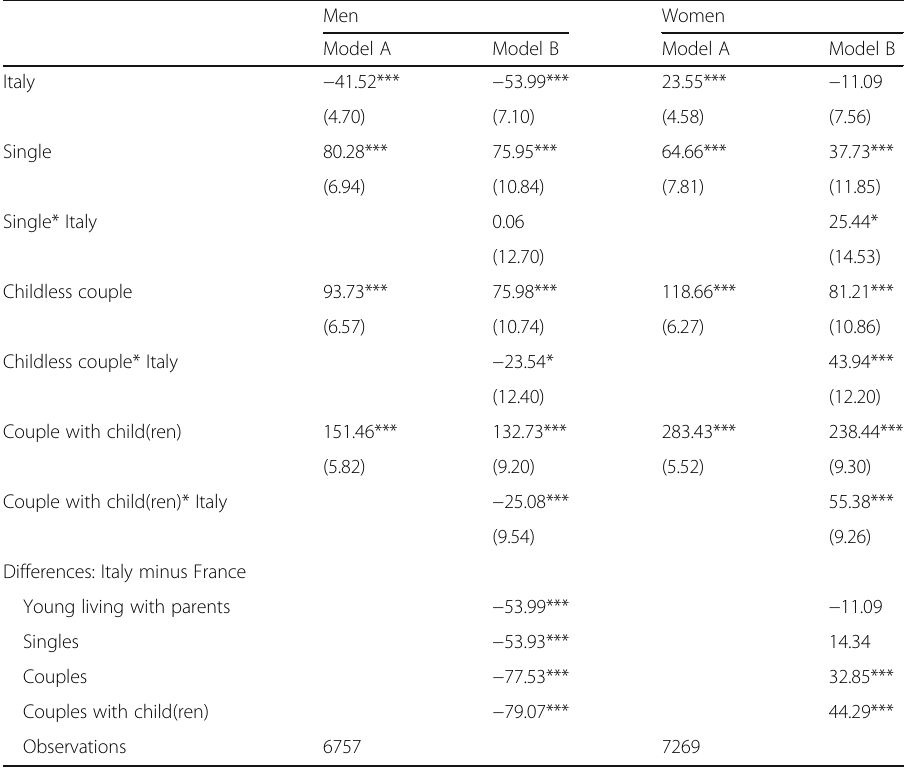
Table 6 Participation in domestic activities in minutes per day by living arrangements and differences in participation between Italians and French (Tobit